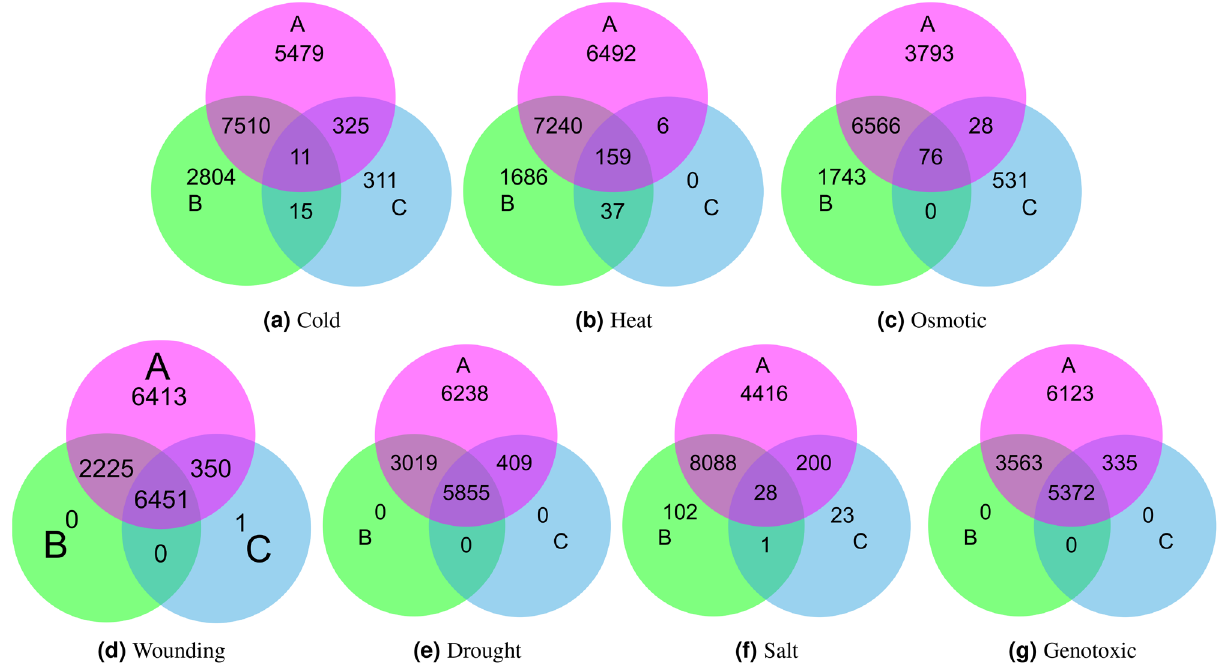
Figure 3. Venn diagram of gene ids extracted after graph analysis. The venn diagrams represent the count of common and unique genes in A, B, and C subunits in different stress